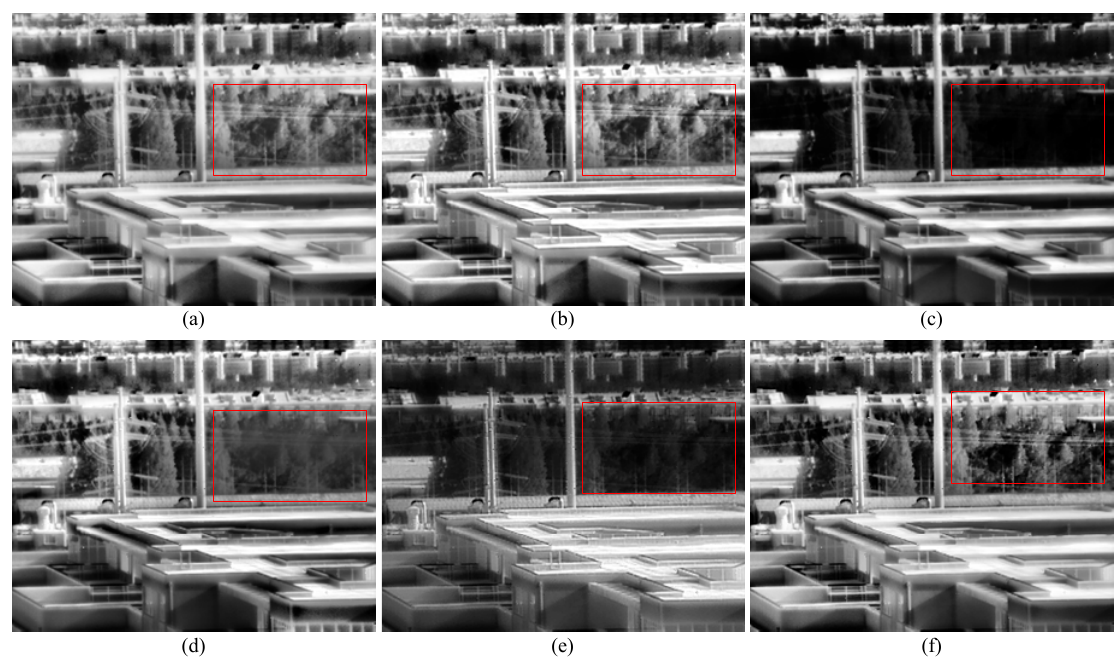
Figure 12. Enhancement results for Trees. ( a ) CLAHE, ( b ) BCCE, ( c ) ABMHE, ( d ) LGGSF, ( e ) GLHS, ( f ) Proposed.